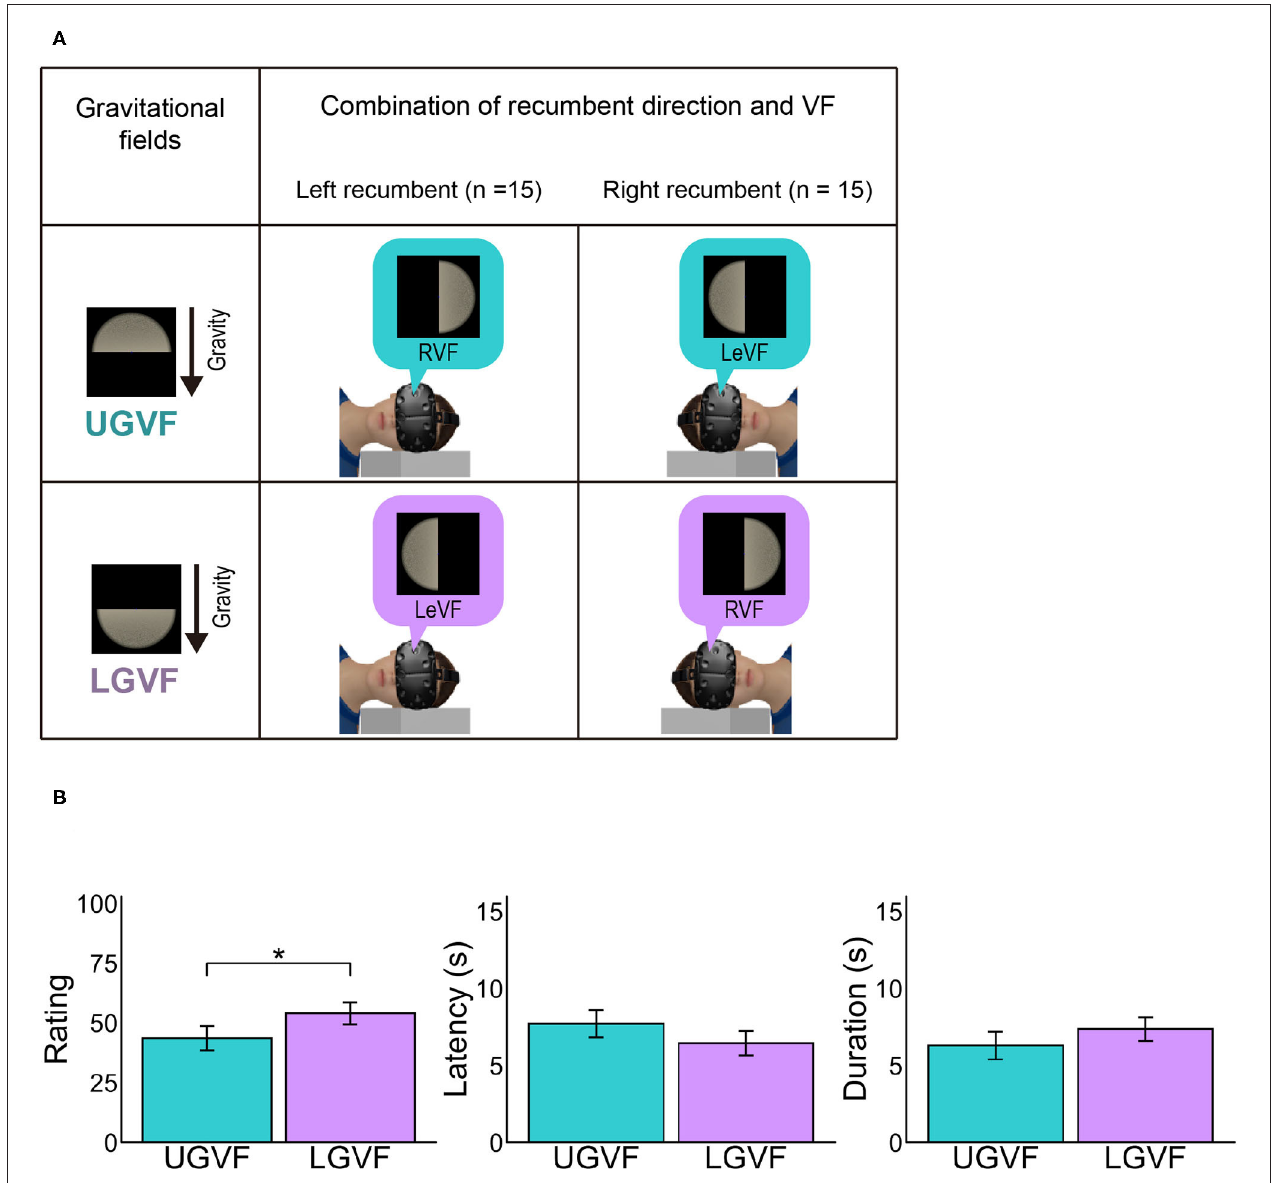
FIGURE 4 | (A) Illustration of upper gravity visual field (UGVF) and lower gravity visual field (LGVF). (B) Mean vection measures for each lateral location of visual field. UGVF refers to the hemi visual field that is positioned at the gravitationally upper location relative to the viewpoint when participants were lying down on their side, while LGVF refers to the hemi visual field at the gravitationally lower location. Error bars represent standard error of the mean across participants * p <